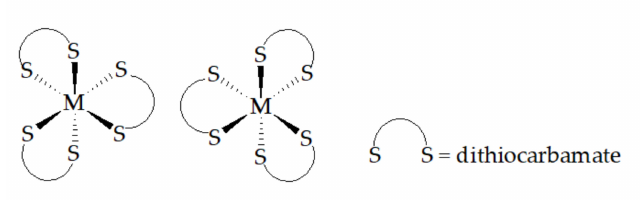
Figure 16. L- and D-forms of [M(L-L) 3